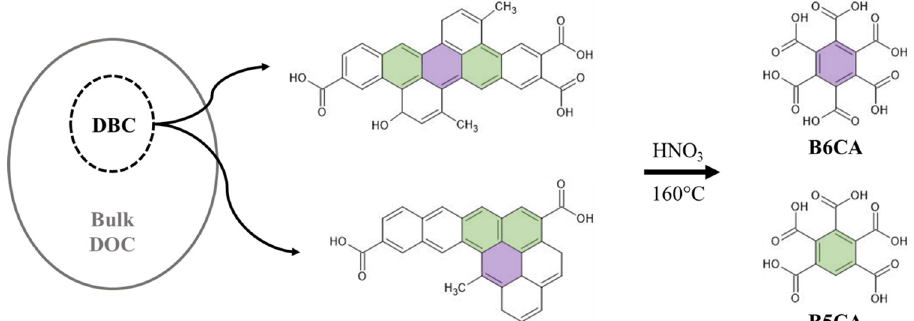
Fig 1. Oxidation of DBC to BPCAs. Dissolved black carbon (DBC) makes up a portion of bulk dissolved organic carbon (DOC). The two examples of possible DBC molecular structures shown were proposed by Dittmar and Paeng [24] based on ultrahigh-resolution mass spectral analysis of ocean water by Dittmar and Koch [25]. When black carbon molecules are oxidized with nitric acid and heat, they produce benzenepolycarboxylic acids (BPCAs). Oxidation products from highly condensed aromatic structures would include highly substituted BPCAs; benzenehexacarboxylic acid (B6CA) and benzenepentacarboxylic acid (B5CA). Structural regions of the two exemplary DBC molecules are colored purple and green to indicate how the condensed aromatic core could oxidize to produce either B6CA or B5CA [16].